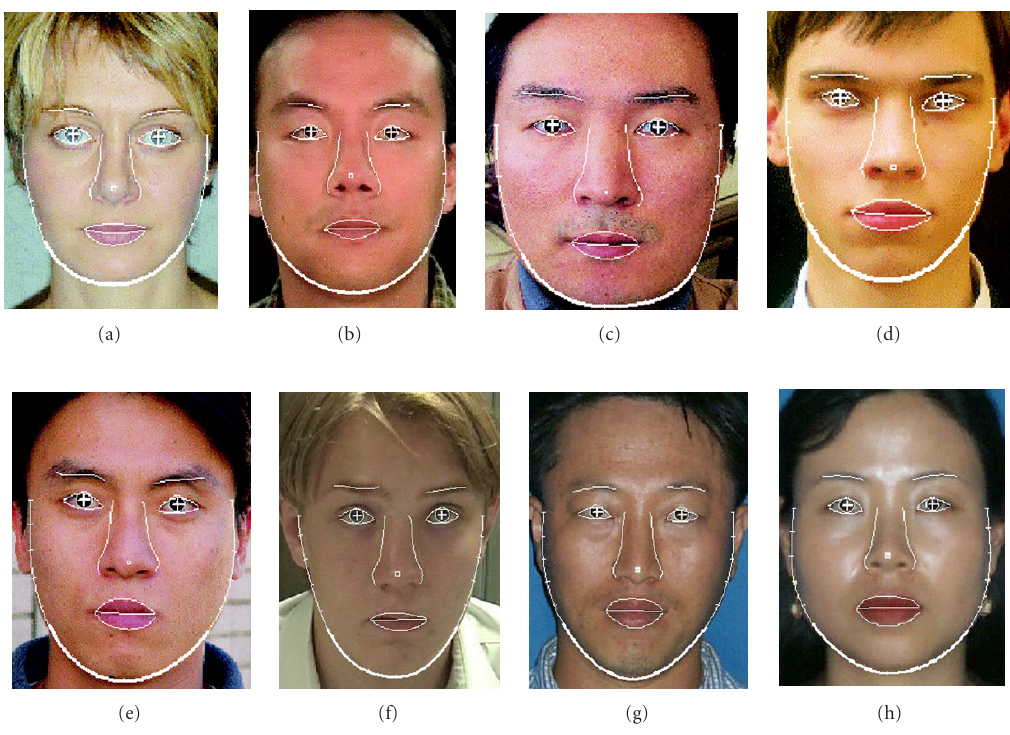
Figure 21: Final results of frontal feature